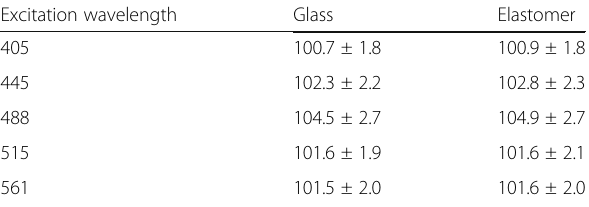
Table 3 Autofluorescence of the elastomer Excitation wavelength